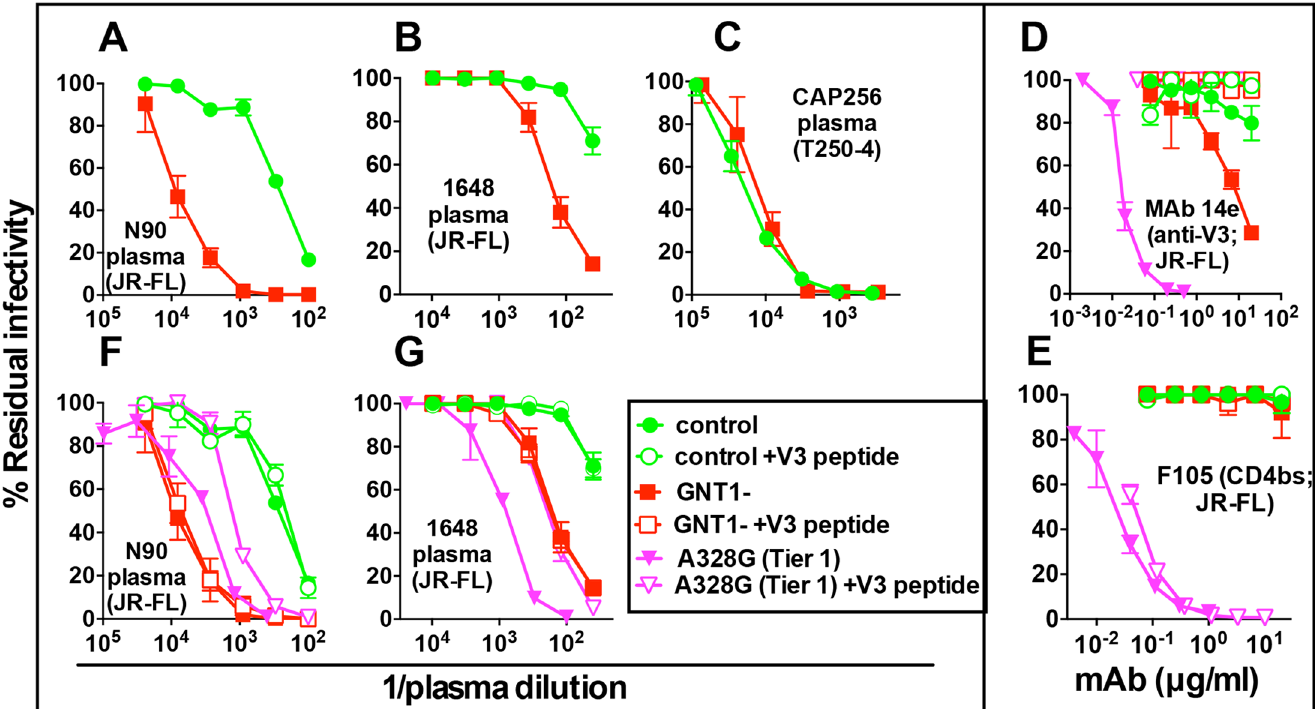
Fig 9. GNT1- PV exhibits a largely V3-resistant tier 2 phenotype. A-C) Comparison of neutralization sensitivities of JR-FL WT control and GNT1- PVs to 3 HIV + donor plasmas. D-G). The neutralization sensitivity of a V3-sensitive tier 1-like A328G mutant of JR-FL WT was compared to the corresponding GNT1- and control PVs. Assays were performed with or without added JR-FL V3 peptides (30 μ g/ml). All assays were performed in CF2 cells and used the JR-FL PV except for CAP256 plasma that used T250-4.